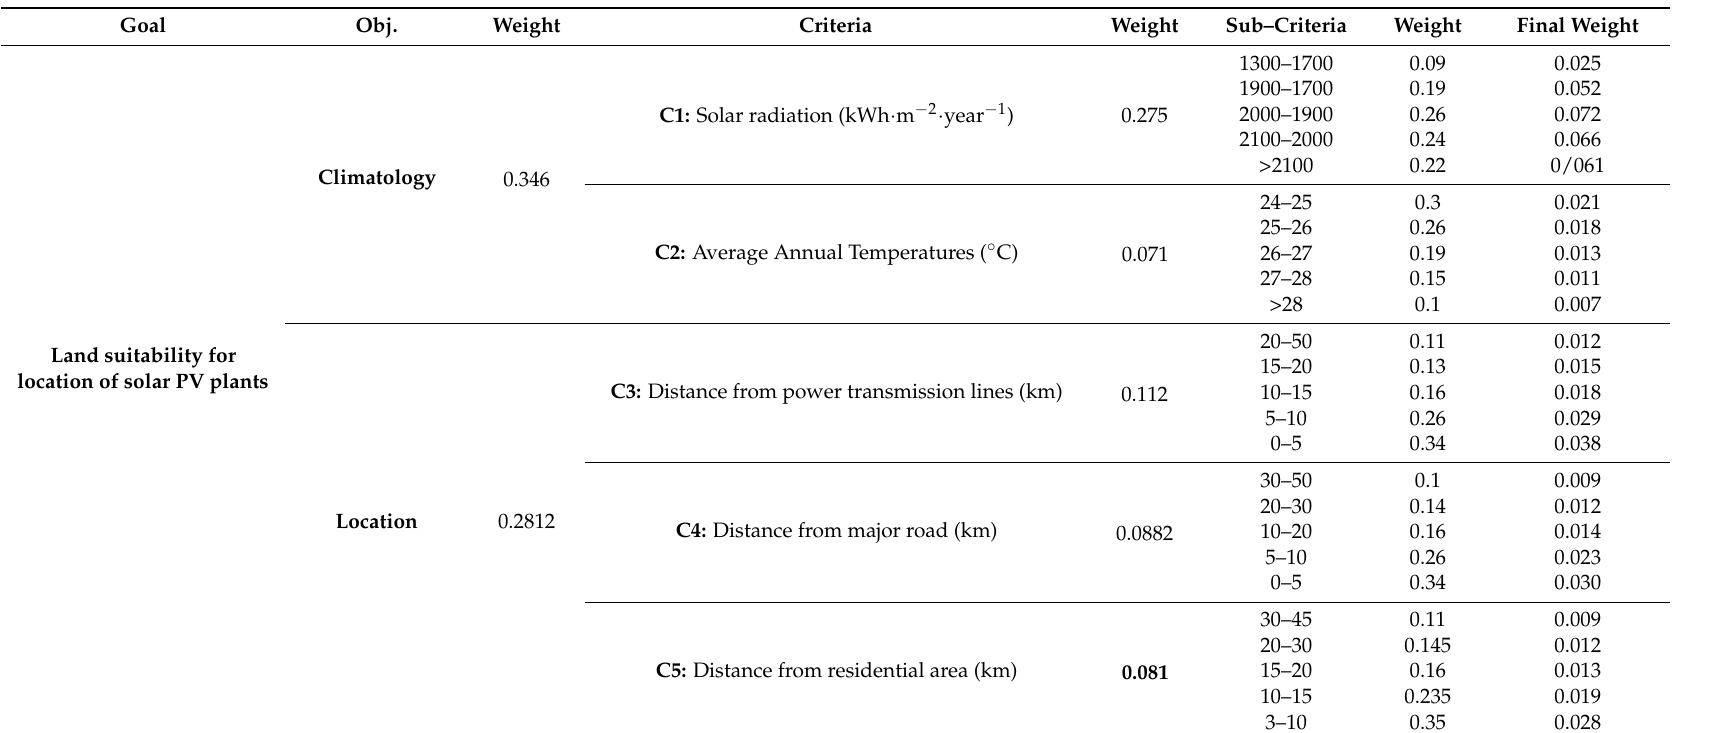
Table 2. The calculated weights for defined criteria and sub criteria by